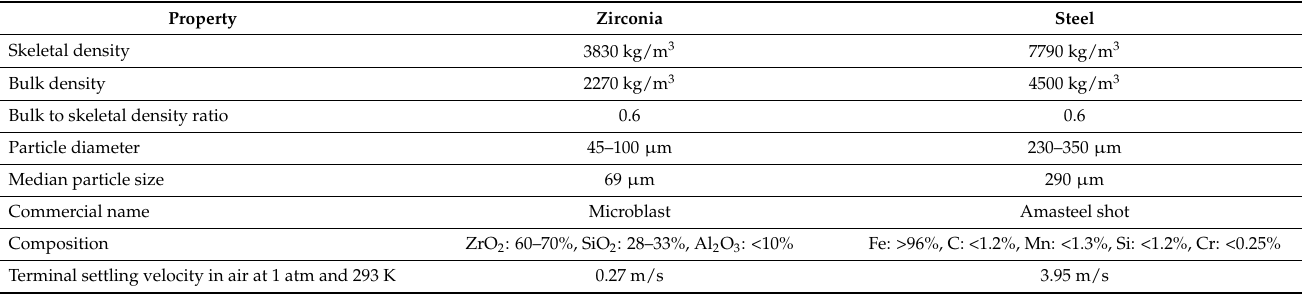
Table 1. Particle